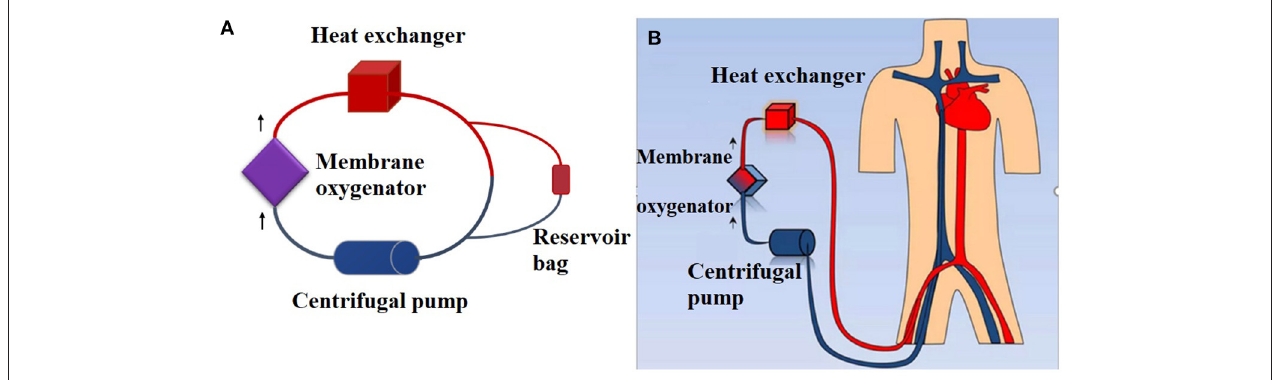
FIGURE 1 | Simulated closed loop ECMO circuits primed with fresh whole human blood. (A) Ex vivo ECMO circuit. A reservoir bag containing 30mL of blood was used to construct a bypass to maintain the pressure of the circuit. A total of 800mL of fresh whole human blood ( < 1h) was used to prime the circuit. (B) In vivo ECMO